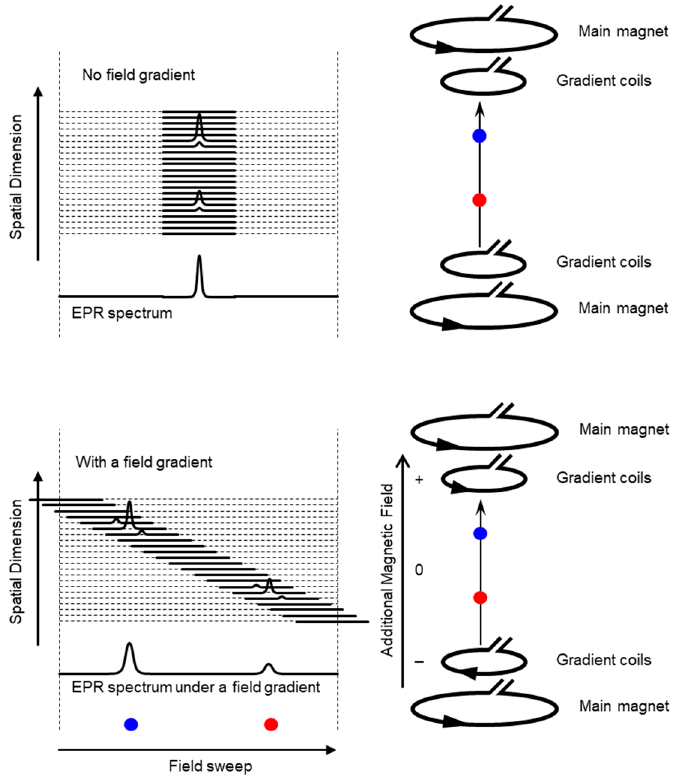
Figure 1. Overloading spatial information on a single resonance EPR spectrum of a free radical by magnetic field gradient. ( Upper panel) Magnetic field is uniformly distributed in the resonator